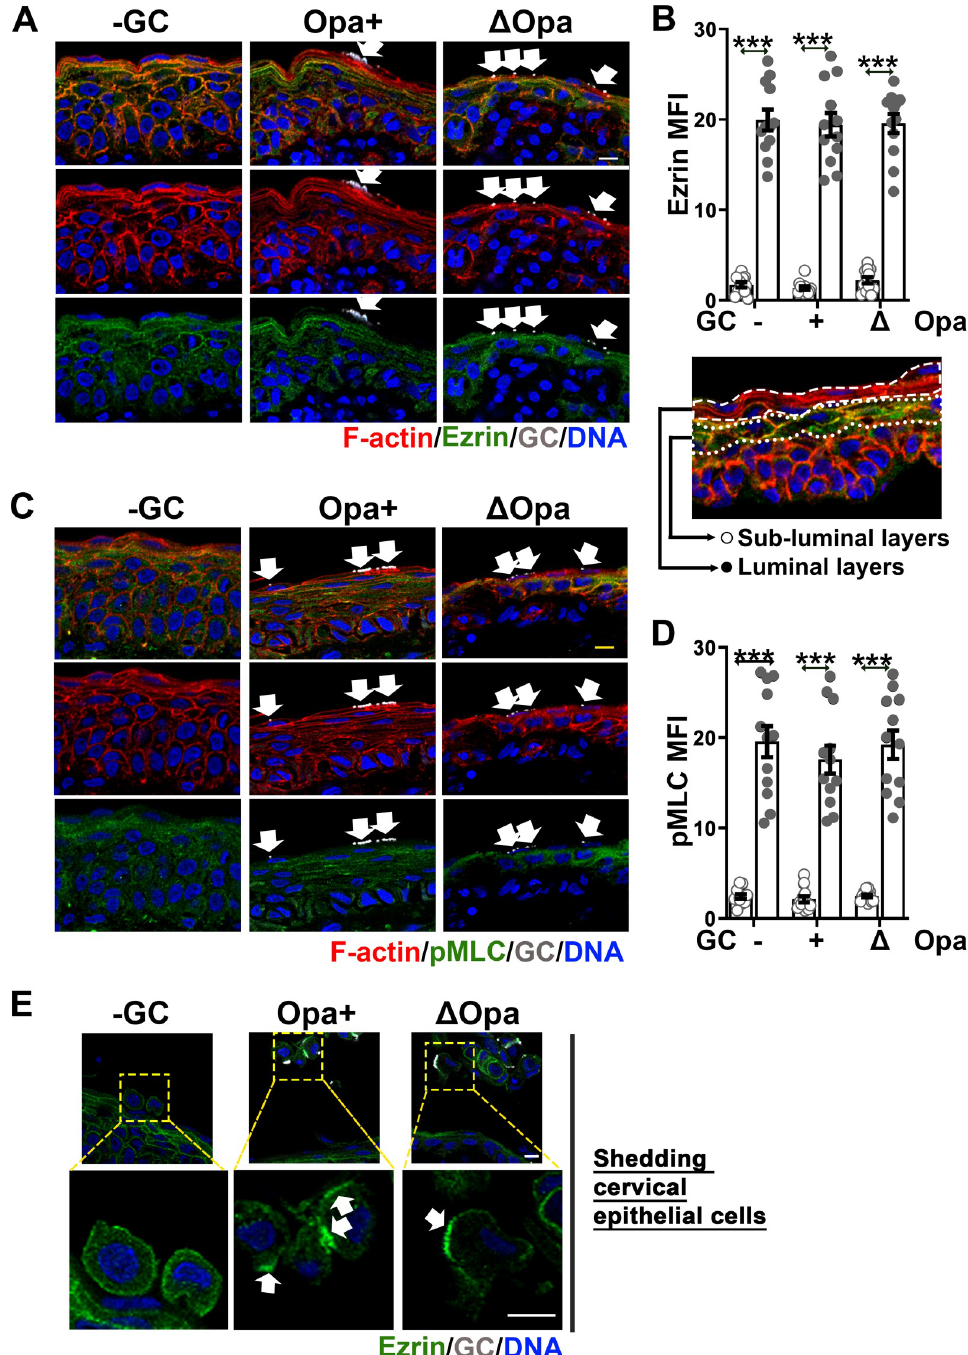
Fig 7. GC fail to induce ezrin and NMII reorganization in ectocervical epithelial cells. Human cervical tissue explants were incubated with Pil+Opa+ and Pil+ Δ Opa GC (MOI~10) for 24 h and washed at 6 and 12 h to remove unassociated GC. Tissue explants were fixed, stained for ezrin, pMLC, GC and DNA, and analyzed using CFM. (A, C) Shown are representative images of ezrin (A) and pMLC (C) staining in both the luminal and subluminal layers of ectocervical epithelial cells. (B, D) The MFI of ezrin (B) and pMLC (D) in the luminal and the subluminal layers of the ectocervical epithelium. Data points represent individual randomly acquired images. (E) Shown are representative images of shedding cervical epithelial cells displaying ezrin accumulation at GC adherent sites (arrows). Scale bar, 10 μ m. n = 2 two cervixes. ��� p < 0.001.